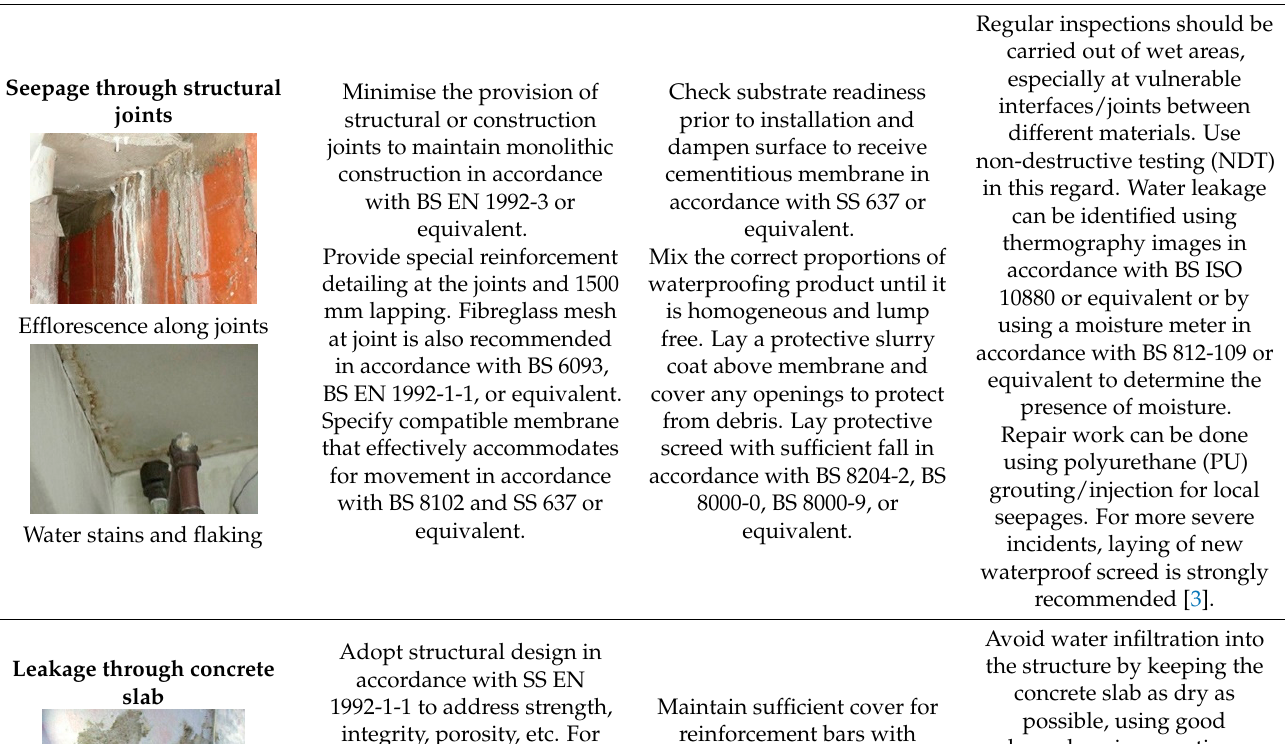
Table 5. Wet Areas—Structural components e.g., floors, slabs, walls, and other load-bearing and non-loading components.